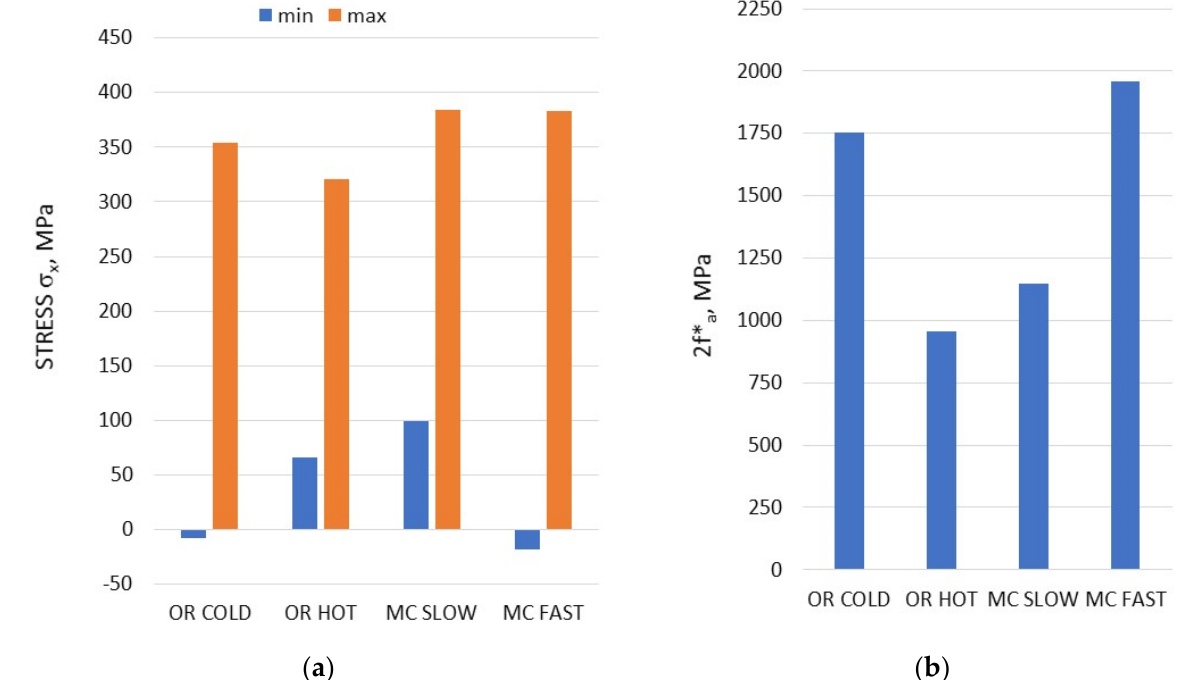
Figure 15. Stress components σ xmax and σ xmin for each startup scenario: ( a ) the stress cycle at point A and ( b ) the equivalent local range of stresses 2f* a.